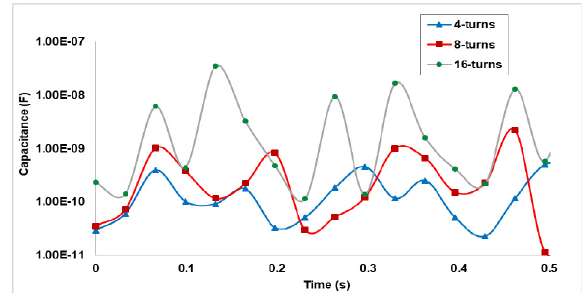
Figure 13. The trend of the equivalent capacitance variations, when the upper movable dielectric, PU, is forward-moving, from x =0 to x=l .